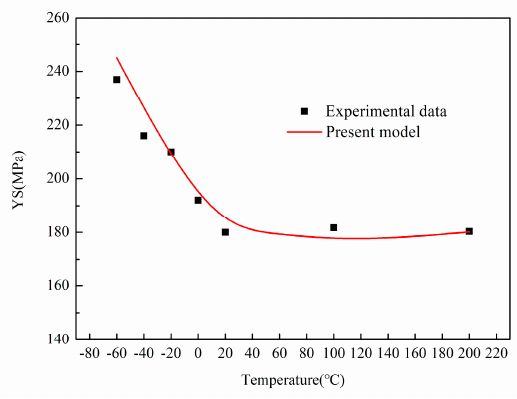
Figure 5. A comparison of the theoretical model and the experimental data at different temperatures.